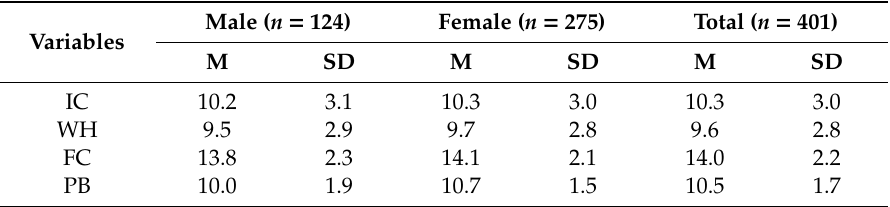
Table 6. Participants’ Social Distance Scale (v1) subscale scores by gender 1